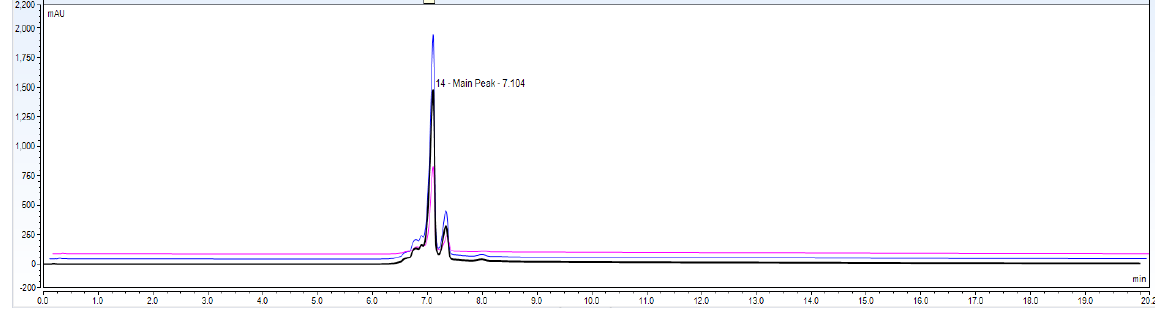
Figure 7. Chromatographic overlay for repeatability experiment using 6 different sample prepara- tions of IgG1 sample 3.0 mg/mL concentration.